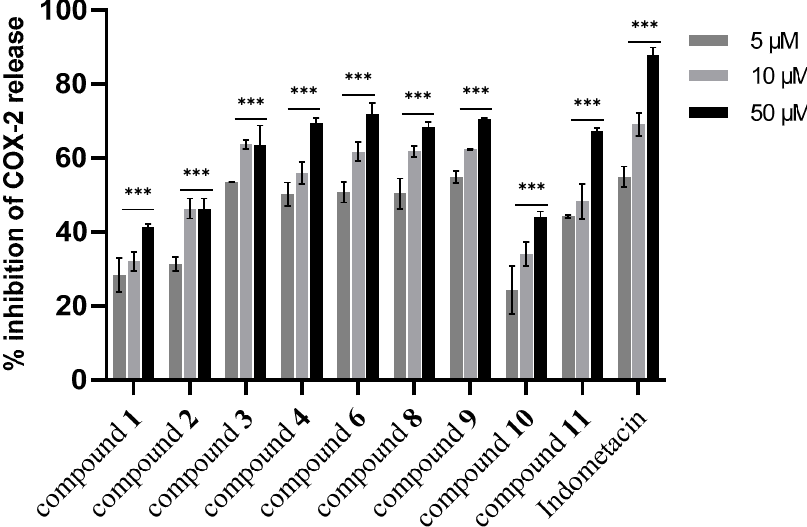
Figure 6. Effect of isolated compounds from aerial parts of Dionysia diapensifolia on COX-2 expression in J774A.1 macrophages (n = 3). Data are expressed as mean ± S.E.M.; *** denotes p < 0.001 vs. LPS (1 µg/mL). Indomethacin (5, 10, and 50 µM) was used as a positive control.